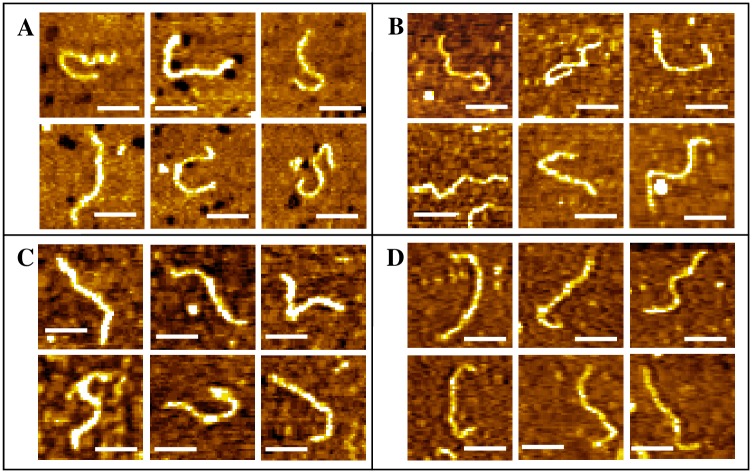
AFM topographs of DNA-daunomycin complex after incubation for (A) 1 h, (B) 18 h, (C) 36 h and (D) 48 h.DNAconc: 1.7 μg.ml-1. Scale bar: 100 nm. Z-ranges: (A) 0–1.2 nm, (B) 0–0.9 nm, (C) 0–0.8 nm and (D) 0–1.2 nm.